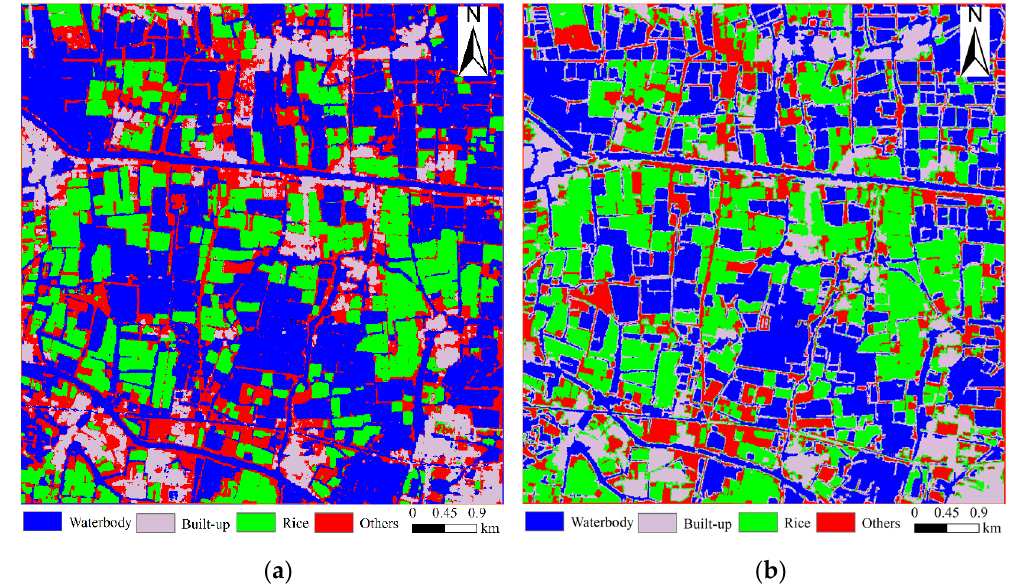
Figure 10. Results of pixel-based ( a ) and superpixel-based ( b ) classification based on S2 + VV + VH dataset.